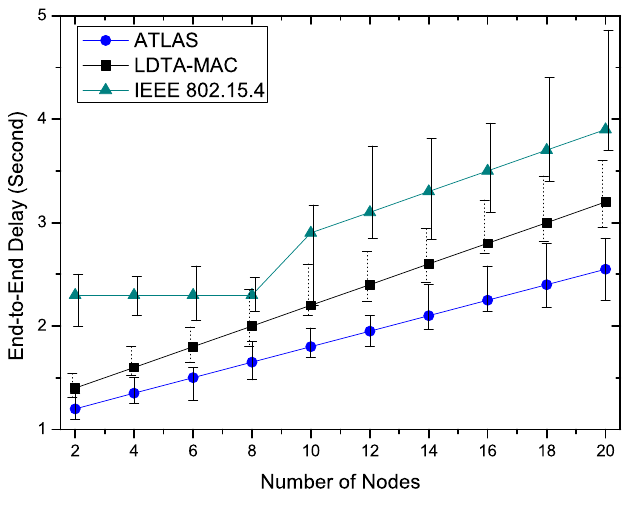
Figure 9. End-to-end delay over different number of